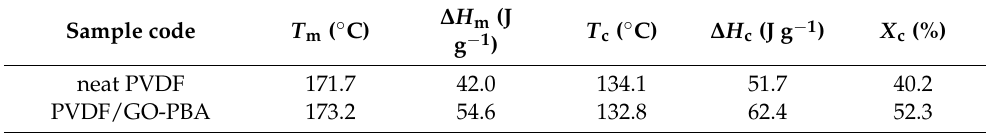
Table 1. Summarized values of the DSC for neat PVDF and PVDF